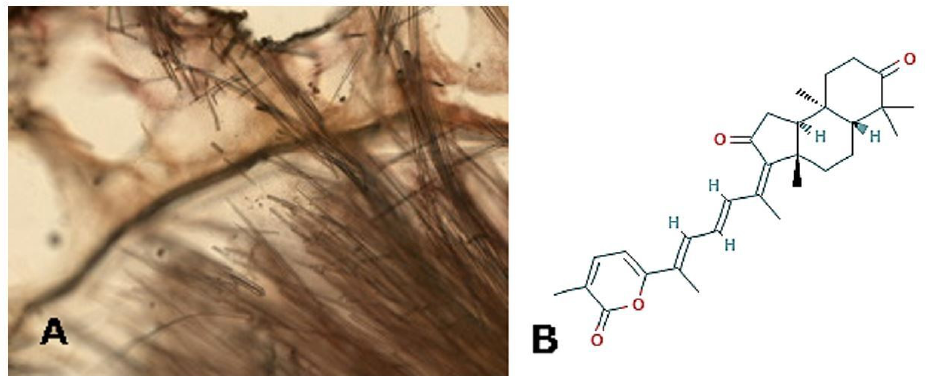
Figure 3. A ) Image of a paraffin section of Jaspis stellifera demosponge. Photo by D. Drew